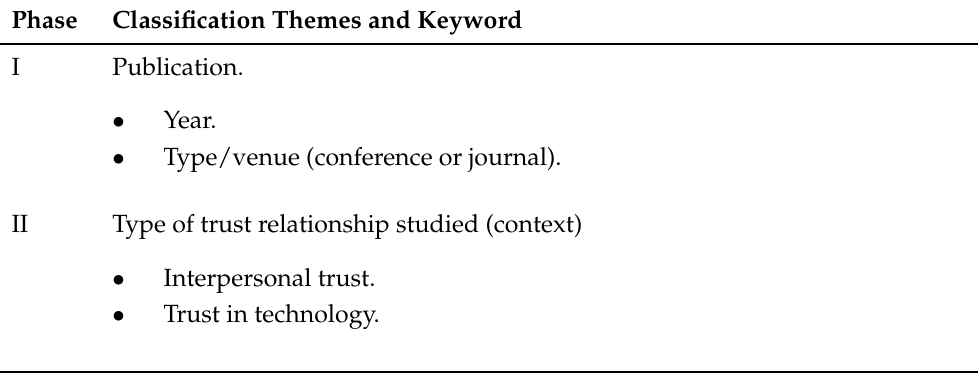
Table 5. Article classification themes and corresponding